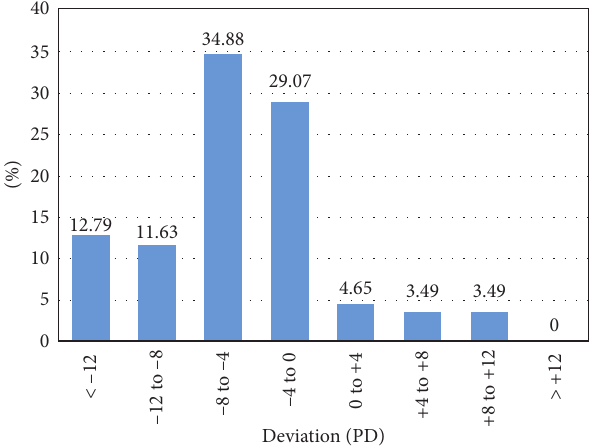
Figure 2: Percentage of children with heterophoria in different magnitude groups at distance fixation for grade-one pupils in Lhasa, Tibet Autonomous Region, China ( n �